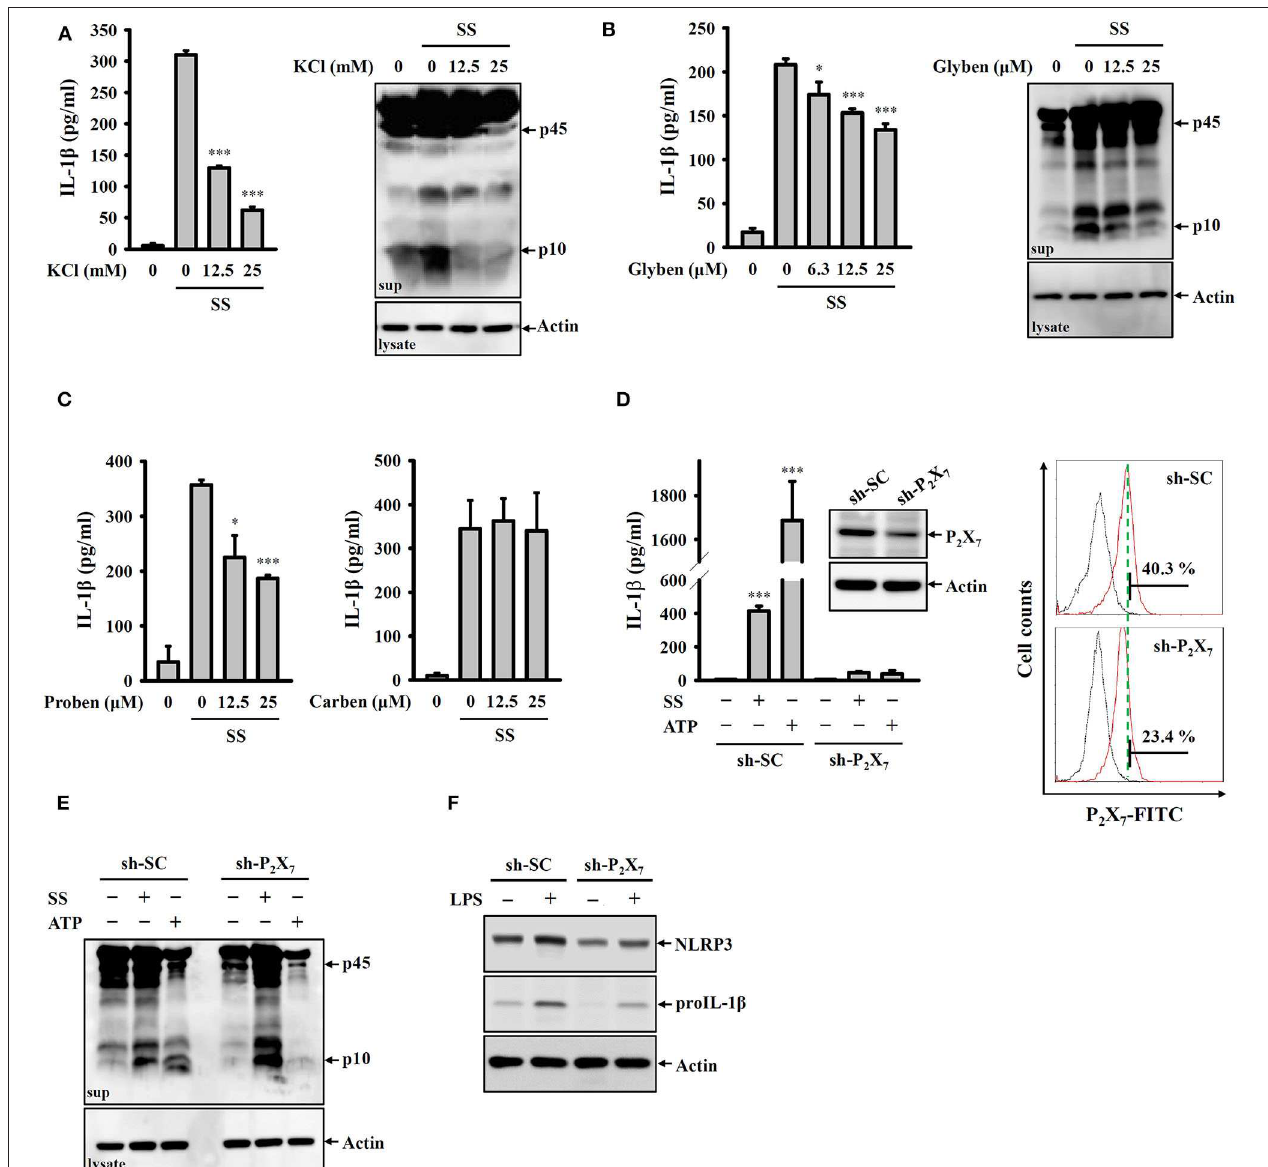
FIGURE 3 | S. sonnei activates the NLRP3 inflammasome through P 2 X 7 receptor-mediated potassium efflux. (A–C) J774A.1 macrophages were primed with 1 µ g/ml LPS for 4h and then treated with KCl (A) , glibenclamide (B) , probenecid or carbenoxolone (C) for 0.5h. The cells were then infected with 50 MOI S. sonnei for an additional 20h. The levels of IL-1 β and caspase-1 in the supernatants were measured by ELISA and Western blotting, respectively. (D,E) Mock or P 2 X 7 knockdown J774A.1 macrophages were primed with 1 µ g/ml LPS for 4h and then infected with 50 MOI S. sonnei for an additional 20h or stimulated with 5mM ATP for an additional 0.5h. The levels of IL-1 β (D) and caspase-1 (E) in the supernatants were measured by ELISA and Western blotting, respectively. The levels of P 2 X 7 in mock or P 2 X 7 knockdown J774A.1 macrophages were measured by Western blotting and flow cytometry (D) . (F) Mock or P 2 X 7 knockdown J774A.1 macrophages were stimulated with 1 µ g/ml LPS for 6h. The levels of NLRP3 and proIL-1 β in the cell lysates were measured by Western blotting. The ELISA data are expressed as the mean ± SD of four separate experiments. The Western blotting results are representative of three different experiments. * and *** indicate significant differences at the levels of p < 0.05 and p < 0.001, respectively, compared to S. sonnei -infected cells (A–C) or untreated control cells (D) (one-way ANOVA with Dunnett’s multiple comparisons